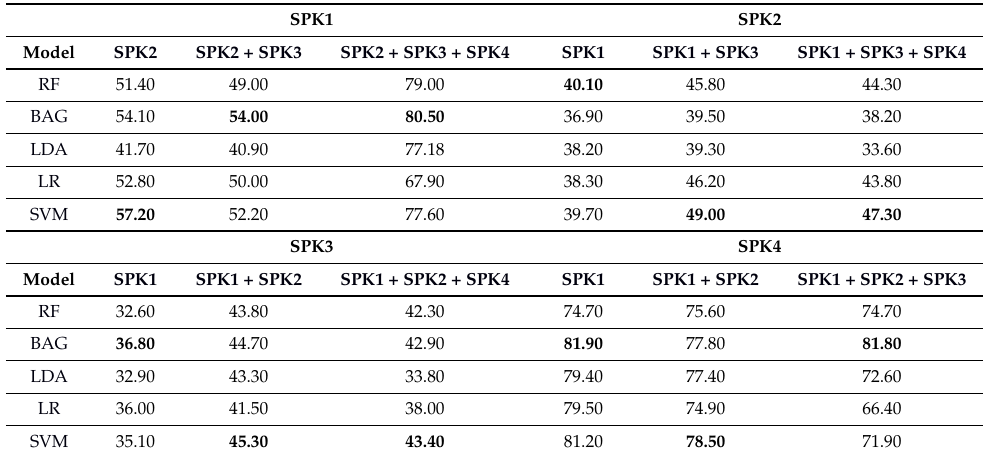
Table 5. Mean accuracy values, produced by all classifiers, for the Inter-Speaker experiment. The data belonging to each speaker were left out for testing, while the models considered for recognition were trained with the data belonging to the remaining speakers. The results were obtained considering the data for the first acquisition session, for each speaker. The highest mean accuracy obtained for each experiment is shown in bold